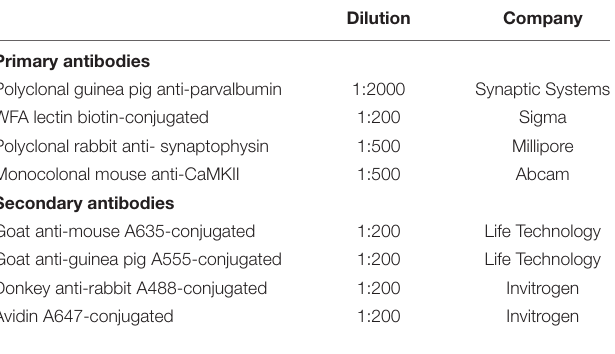
TABLE 1 | List of primary and secondary antibodies used in the study. Dilution